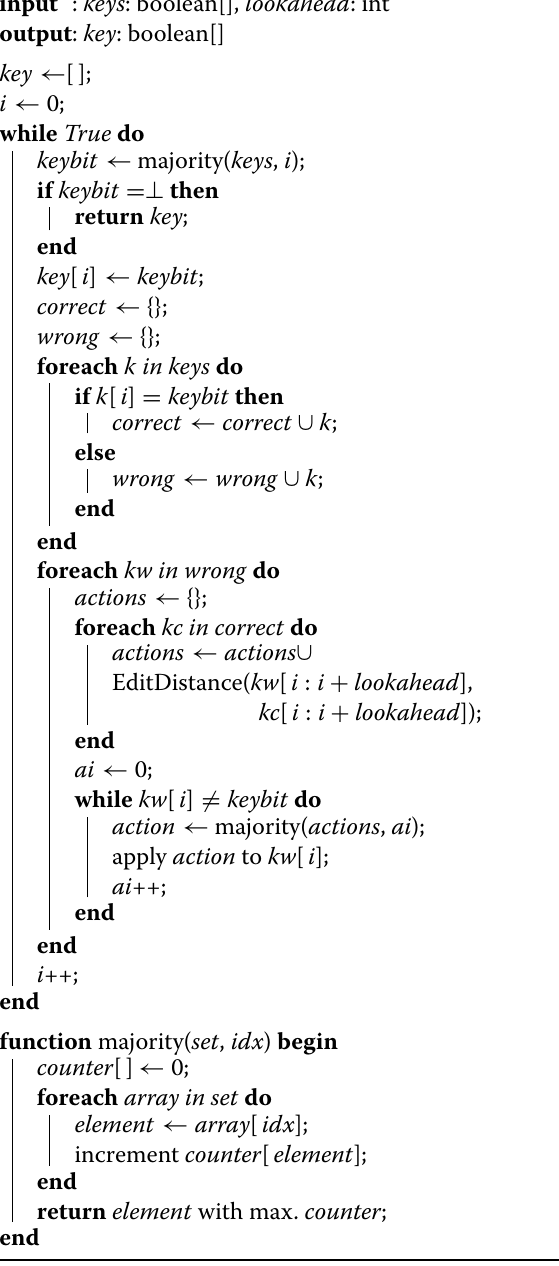
Algorithm 4: RSA private key